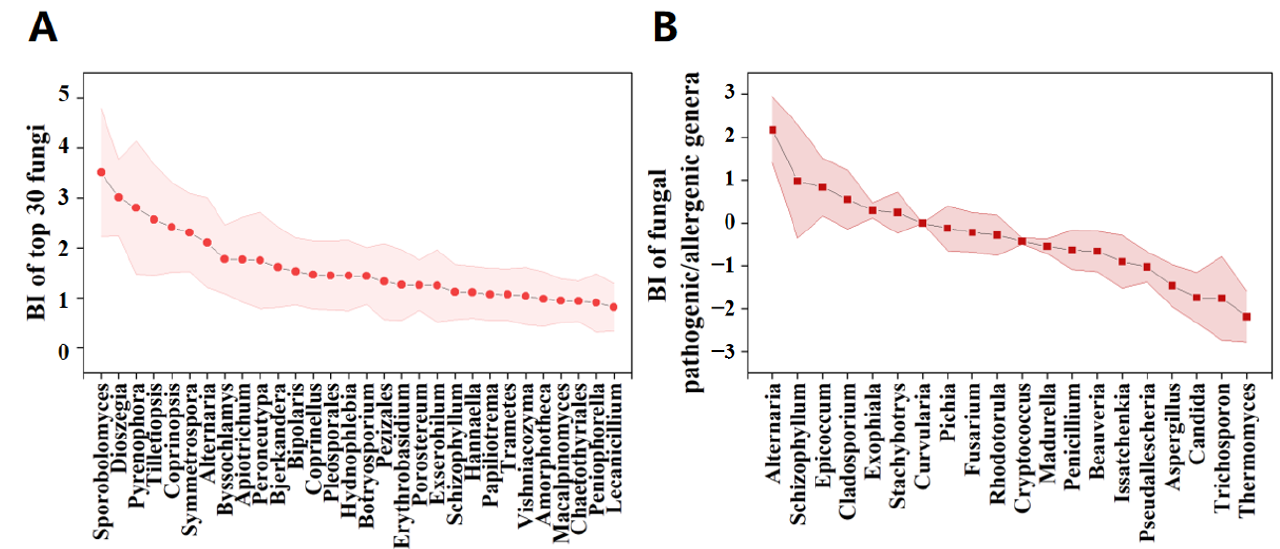
Figure 6. Bioaerosolization Index (BI) of the 30 top fungal genera ( A ) and pathogenic/allergenic genera ( B ) (BI value was t log-transformed).